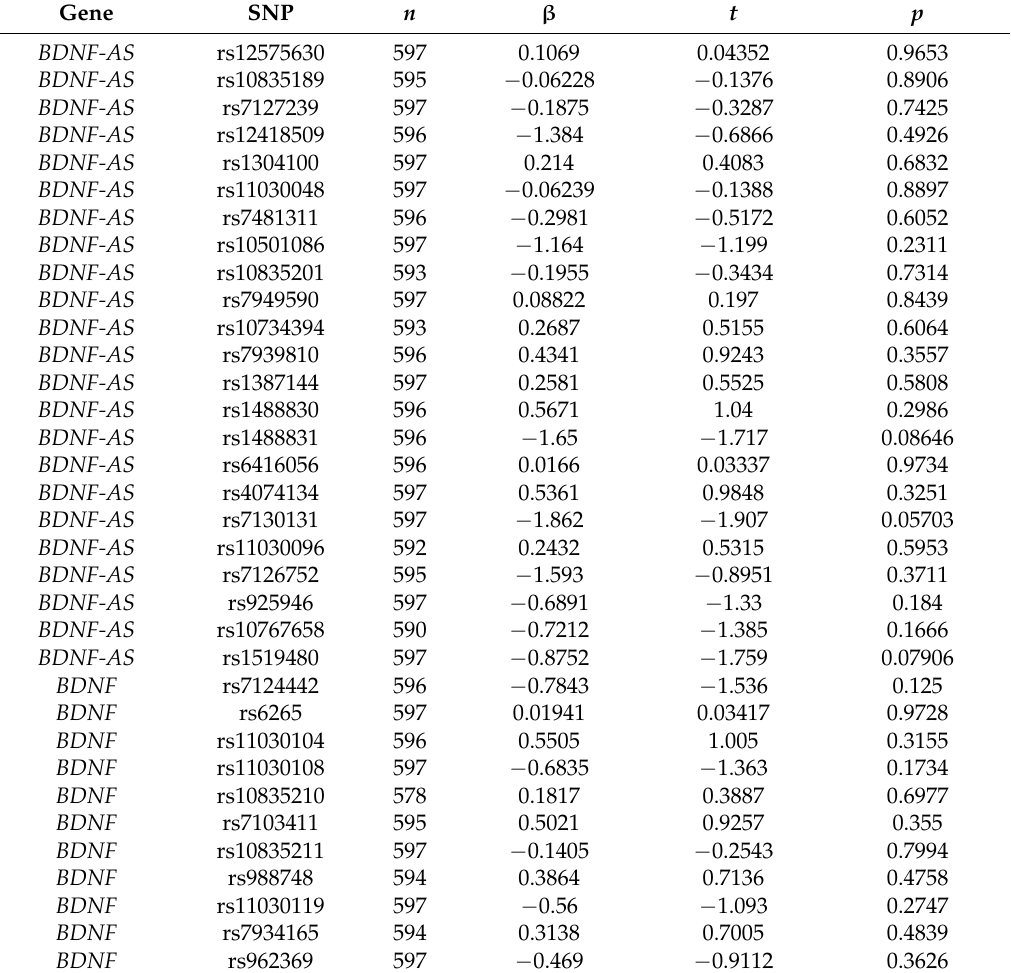
Table 2. Immediate visual memory score (Visual Reproduction I) association with BDNF and BDNF-AS single nucleotide polymorphisms